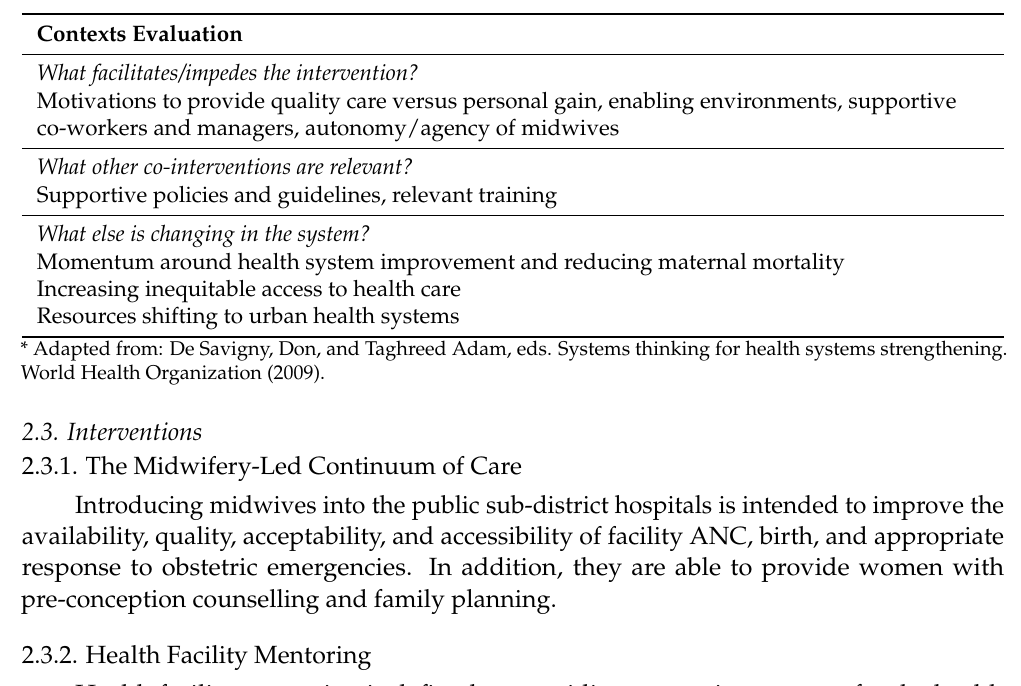
Table 1. Systems thinking evaluation questions for context evaluations